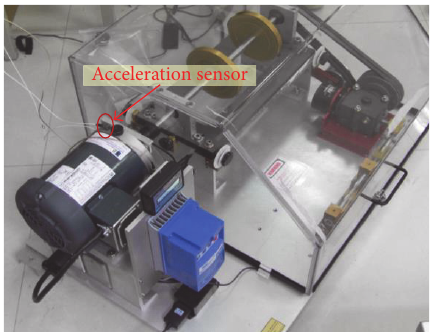
Figure 9: SQI’s mechanical fault